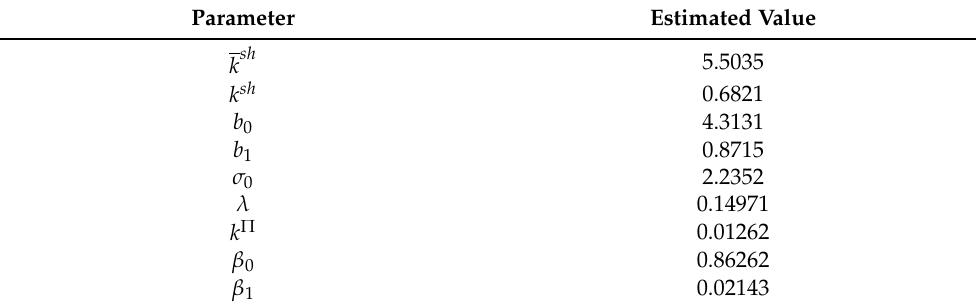
Table 2. The estimated parameters.